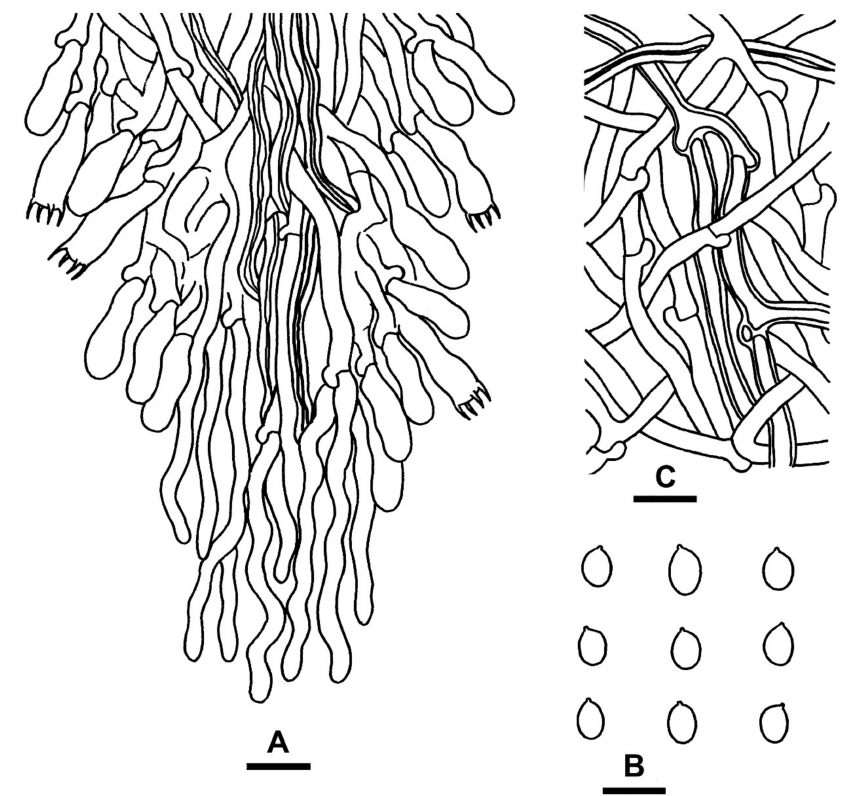
Figure 5. Microscopic structures of Fibrodontia austrosinensis (drawn from the holotype). ( A ) Part of the vertical section of basidiocarp; ( B ) basidiospores; ( C ) hyphae from subiculum. Scale bars: ( A , B , C ) = 10 µ m. MycoBank: MB